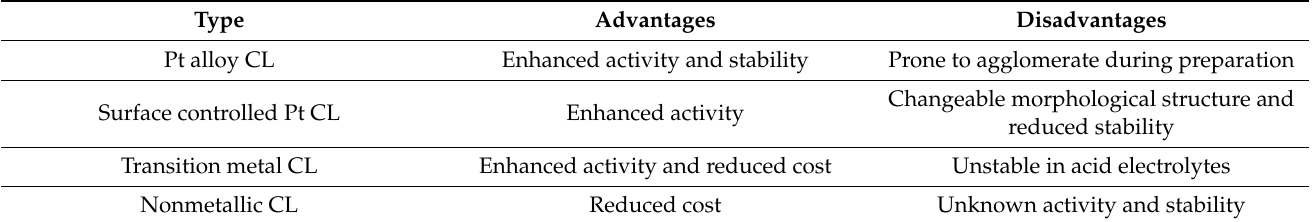
Table 5. Comparison of fuel cell CLs. Type Advantages Disadvantages Pt alloy CL Enhanced activity and stability Prone to agglomerate during preparation Changeable morphological structure and Surface controlled Pt CL Enhanced activity reduced stability Enhanced activity and reduced cost Unstable in acid electrolytes Reduced cost Unknown activity and